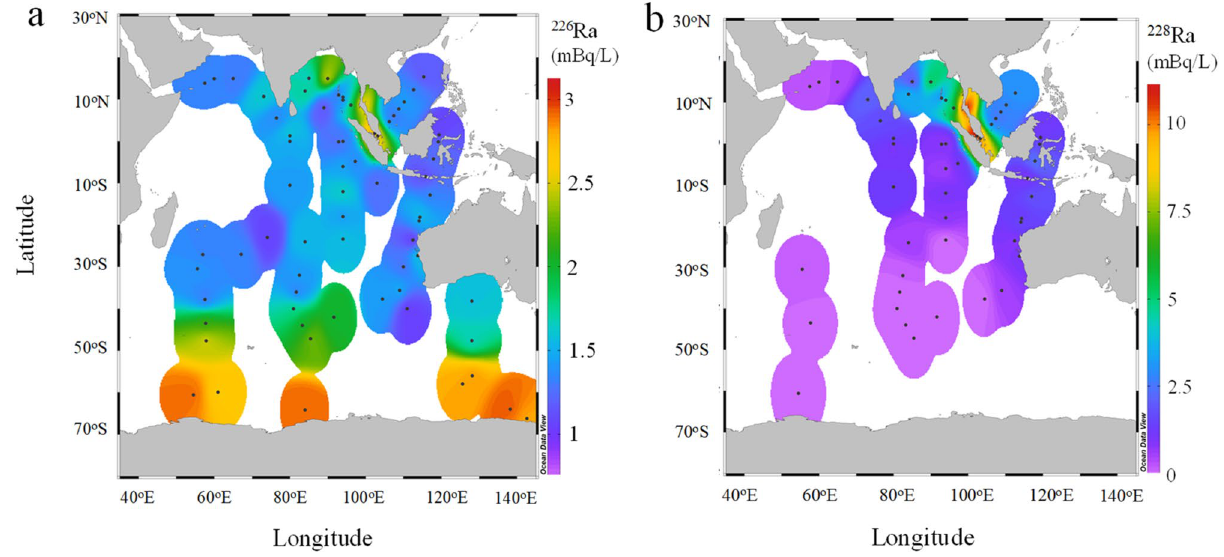
Figure 2. Lateral profile (depth ≤ 10 m) of ( a ) 226 Ra and ( b ) 228 Ra concentrations (January–April) in the Indian and Southern Oceans, along with data from previous studies 20–25 . The map in this figure was drawn using Ocean Data View ver. 5.5.1 (http:// odv. awi.